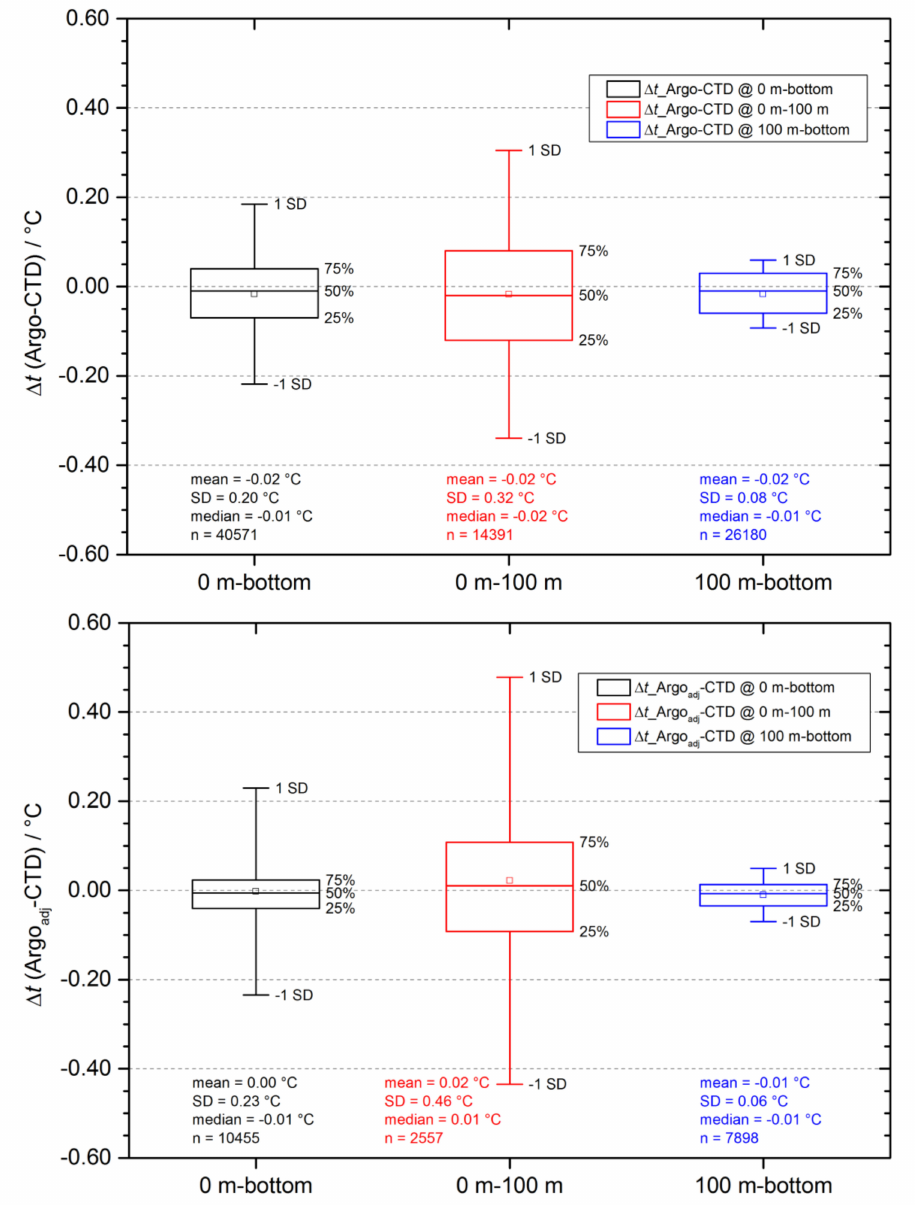
Figure 14. Box plot of temperature di ff erences: Argo (not-adjusted, top , and adjusted, bottom ) vs. CTD. Mean values are indicated by empty